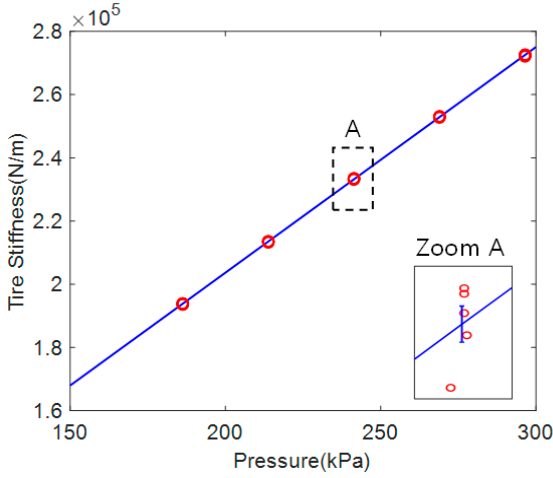
5 of 20 Table 1. Measurement of tire vertical stiffness with different pressure. Pressure (psi)